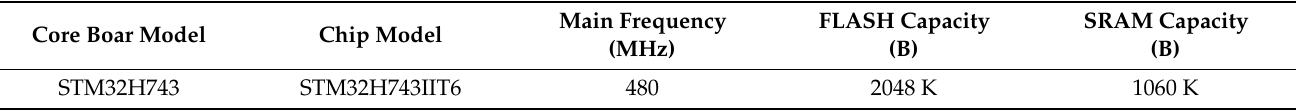
Table 8. Information of the Keil V5.